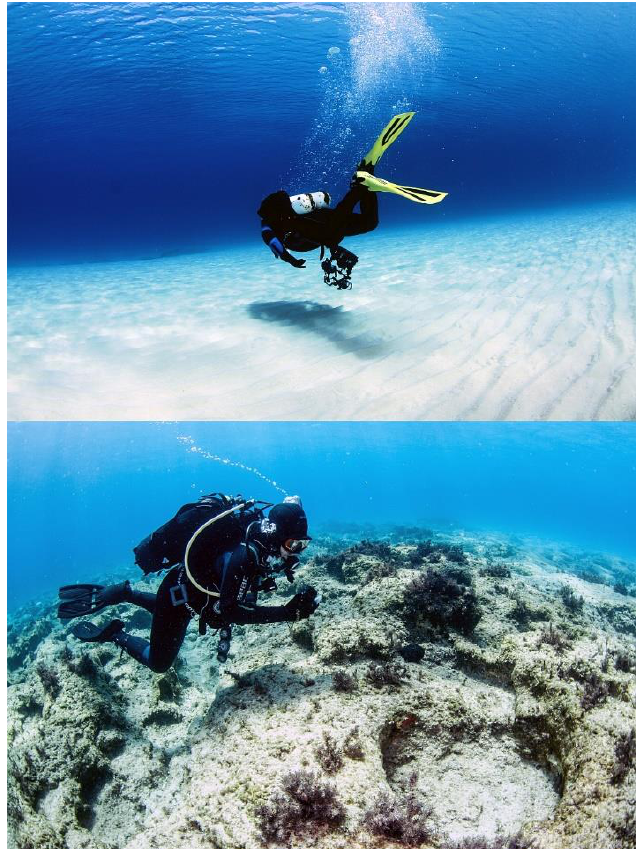
Figure 3. The two seabed cover types in the project area; above: sandy soft bottom, below: carbonated rocky surfaces partially covered by brown macroalgae.